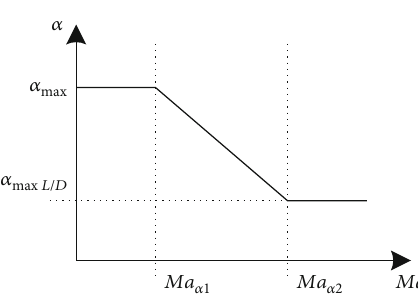
Figure 5: Pro fi le of the angle of